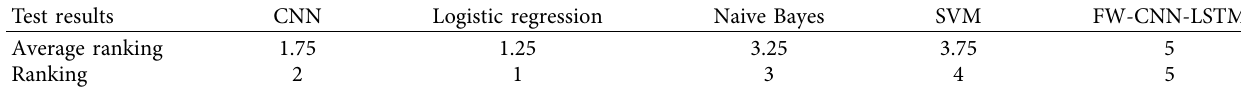
Table 9: Average ranking of Friedman’s test for the comparing algorithms of the Taobao dataset.